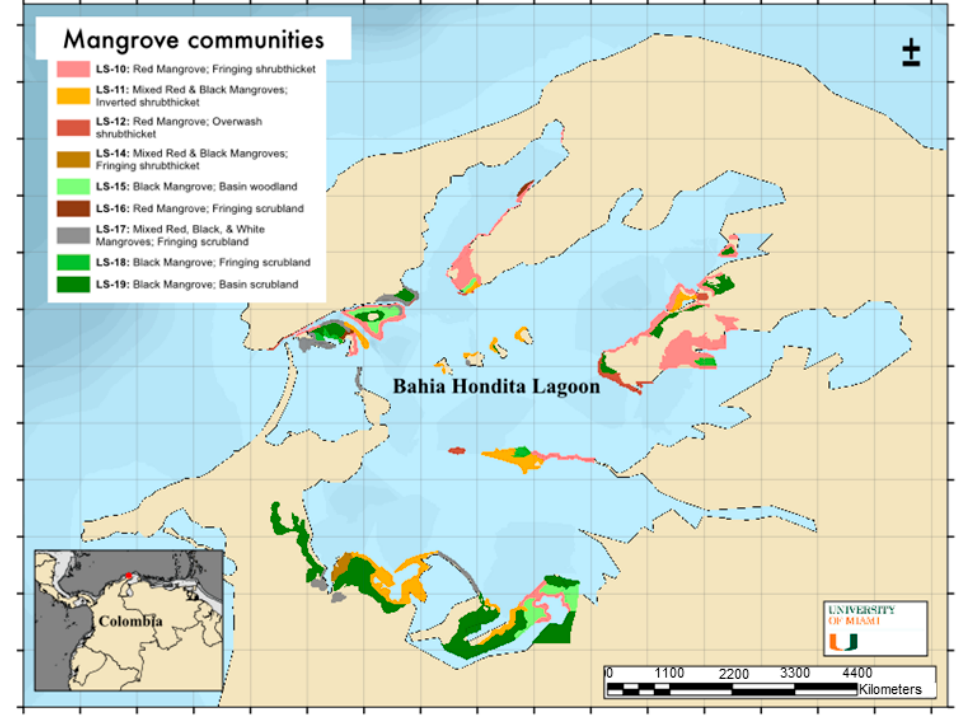
Figure 3. Map of the diverse mangrove shoreline biotopes of the Bahia Hondita marine lagoon (12.403° N, 71.695° W), northeastern Guajira. Map was created from Google Earth Images and ground-truthing of location points from 2016, using ArcGIS (Esri, 2012).